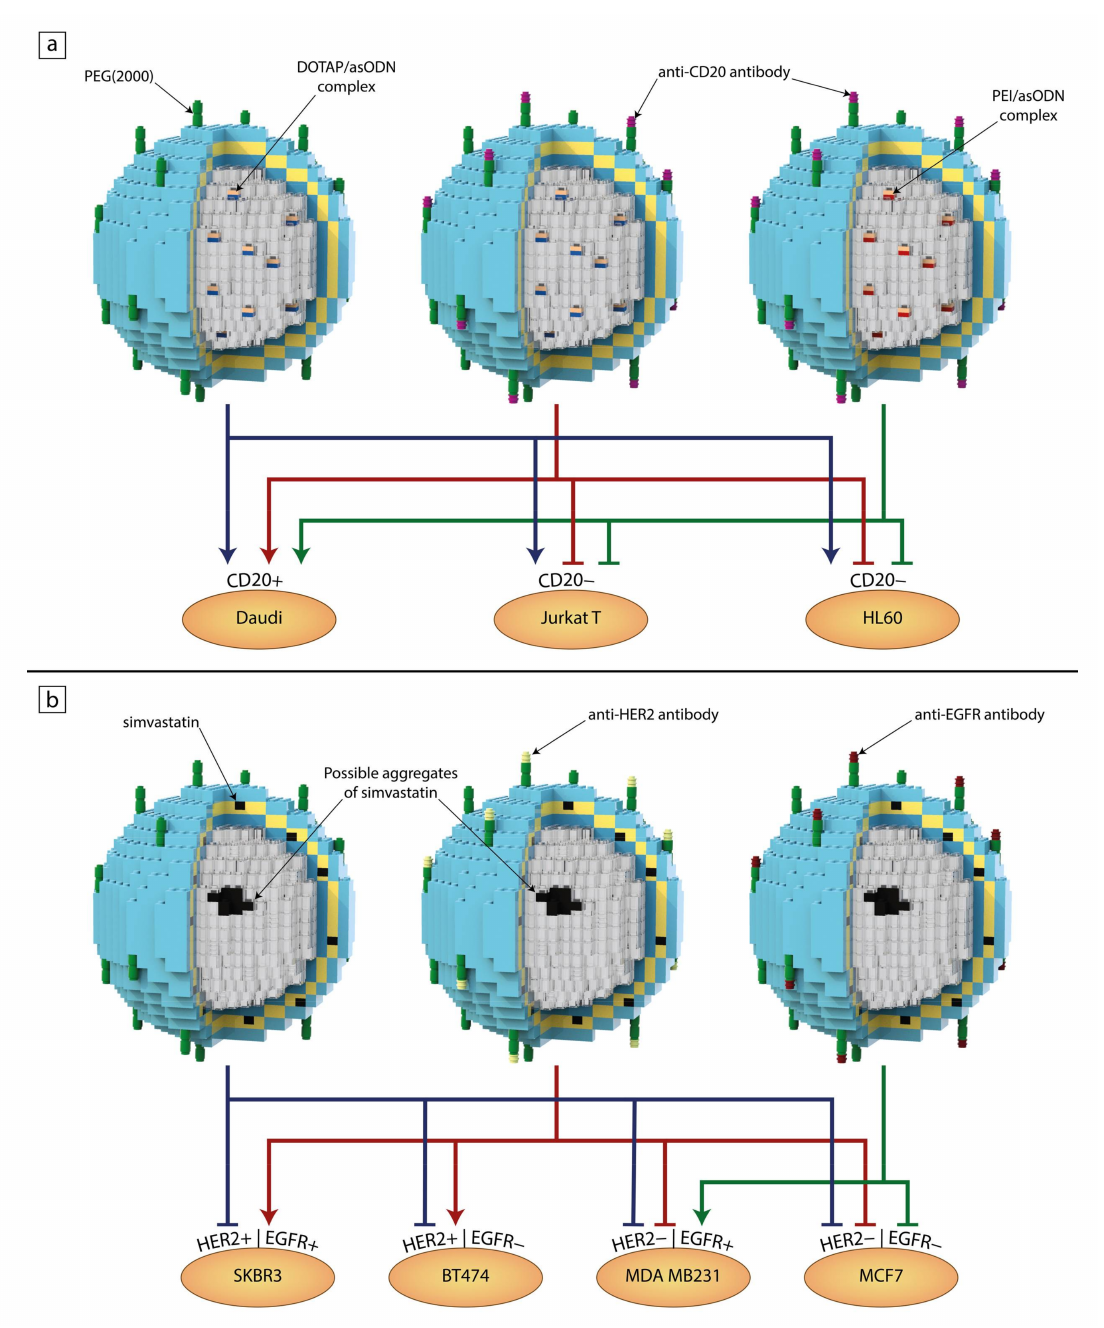
Figure 5. The interchangeability of individual blocks resulting in di ff erent or synergistic e ff ects on individual cell lines after treatment with liposomal formulations containing antisense oligonucleotide (asODN) complexes ( a ) [136,137] and simvastatin ( b ) [66,138]. Arrows show a noticeable decrease in cell viability and / or interactions with cells, while blind-ended arrows indicate a lack of a significant e ff ect after the addition of liposomes to the cell culture